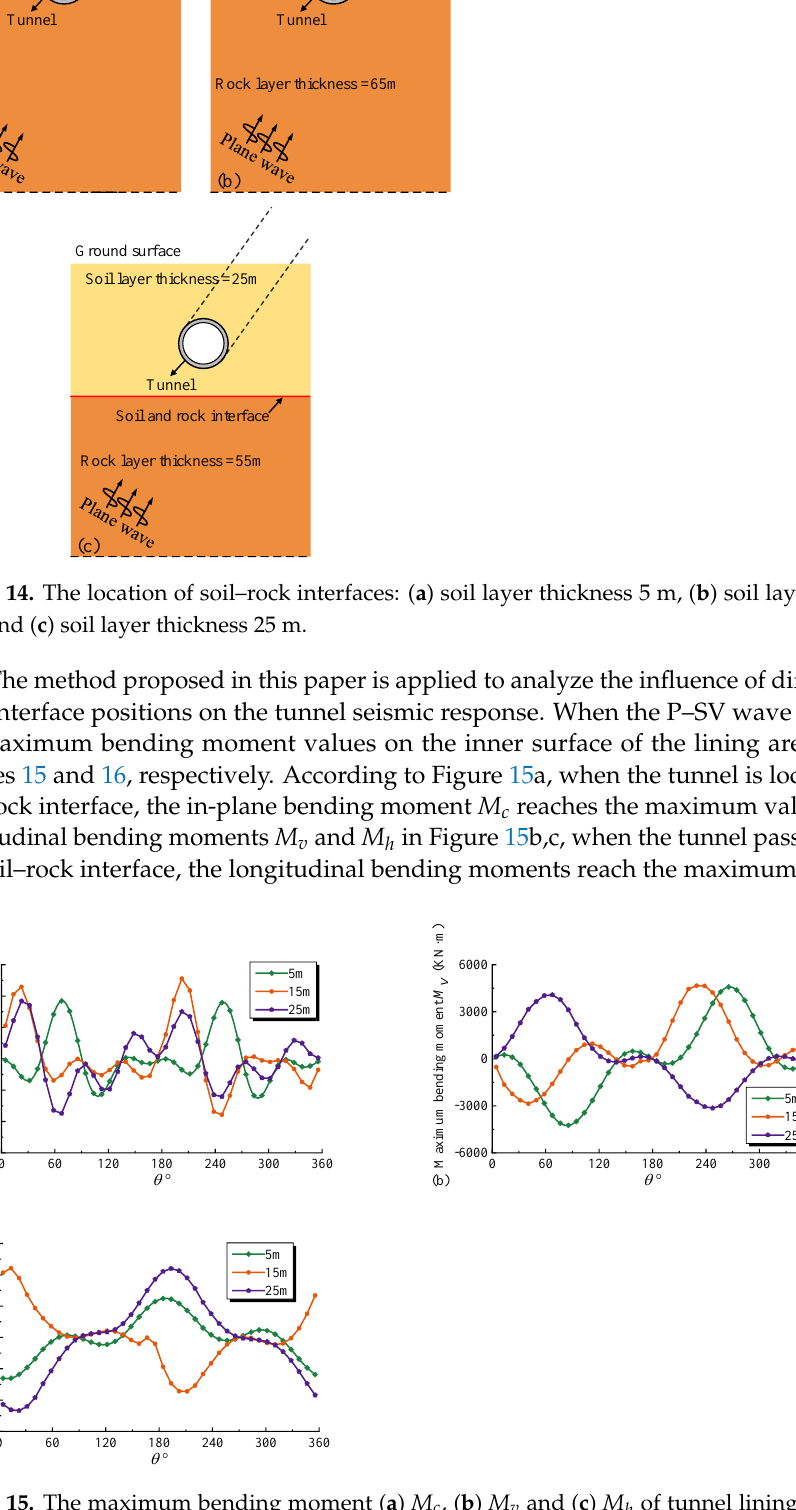
Figure 15. The maximum bending moment ( a ) M c , ( b ) M v and ( c ) M h of tunnel lining at different soil–rock interfaces when P wave is incident.